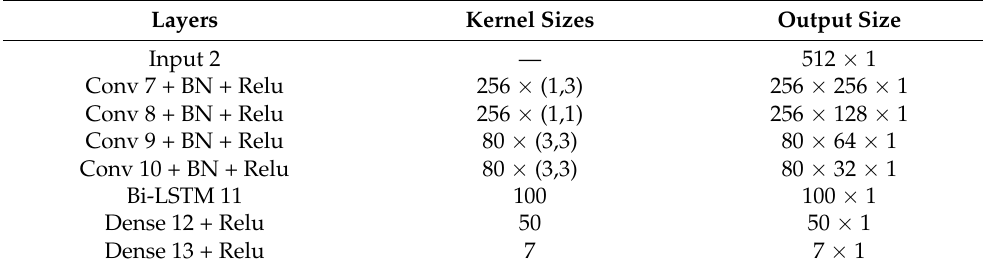
Table 5. 1D-CNN Parameters.